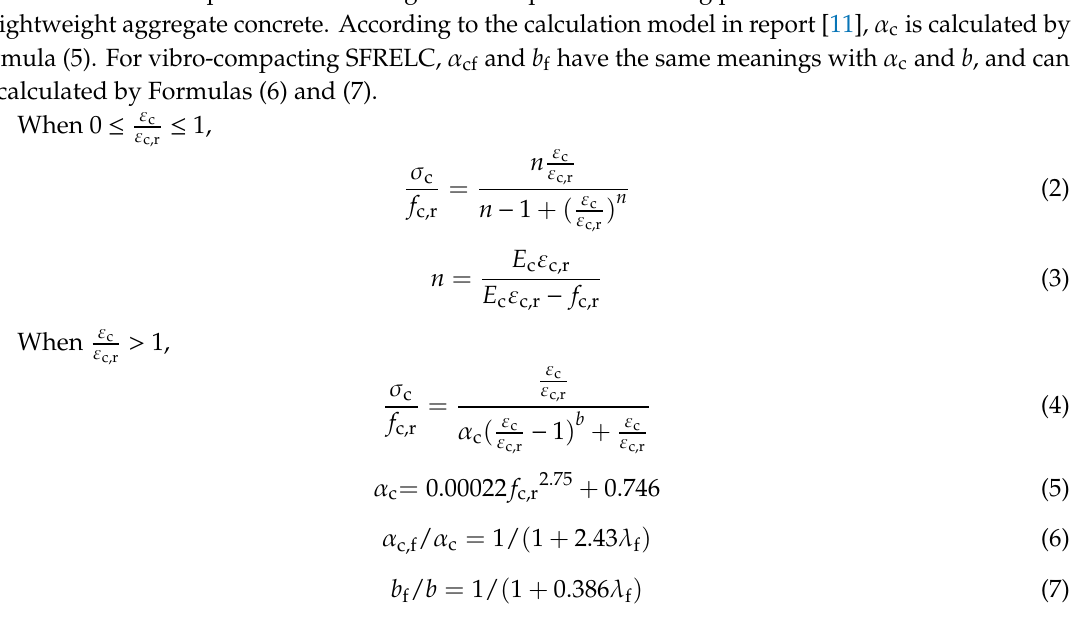
Figure 16. Relationship between λ f and b f / b. The relationship between ε cu / ε c,r and α c or α c,f is shown in Figure 17, which fits the formula (8) specified in China Code GB50010 for conventional concrete as follows [45], cu